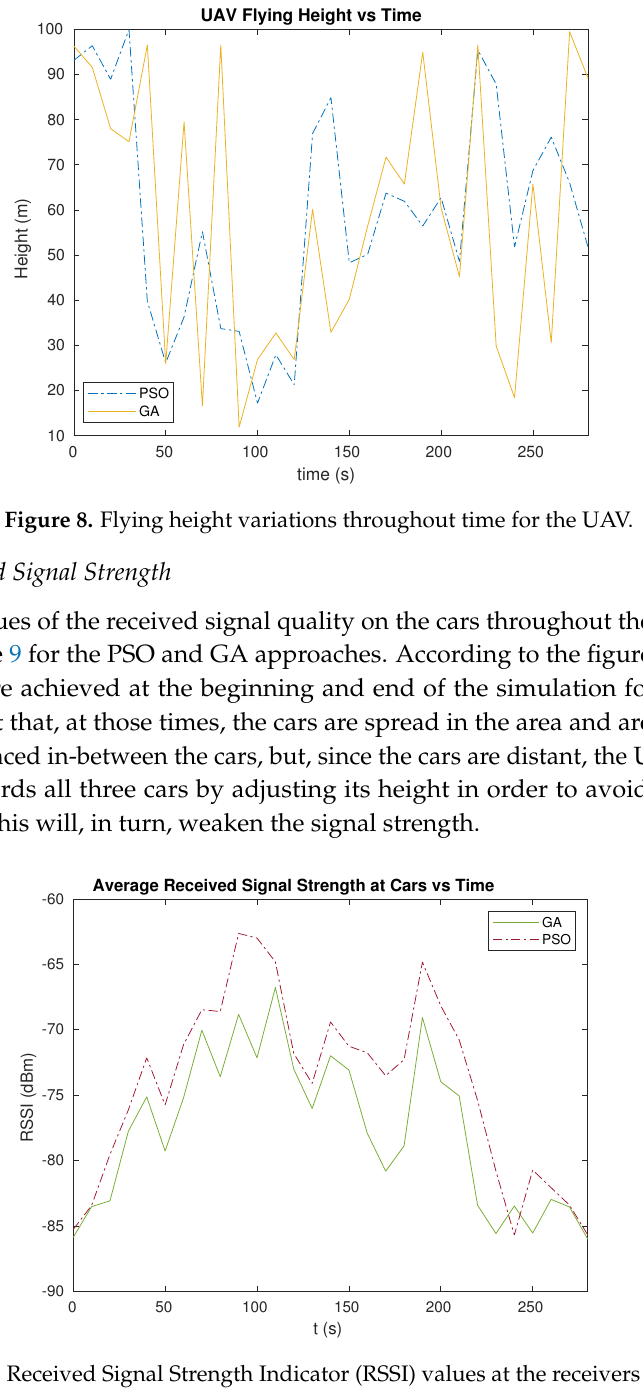
Figure 9. Average Received Signal Strength Indicator (RSSI) values at the receivers throughout